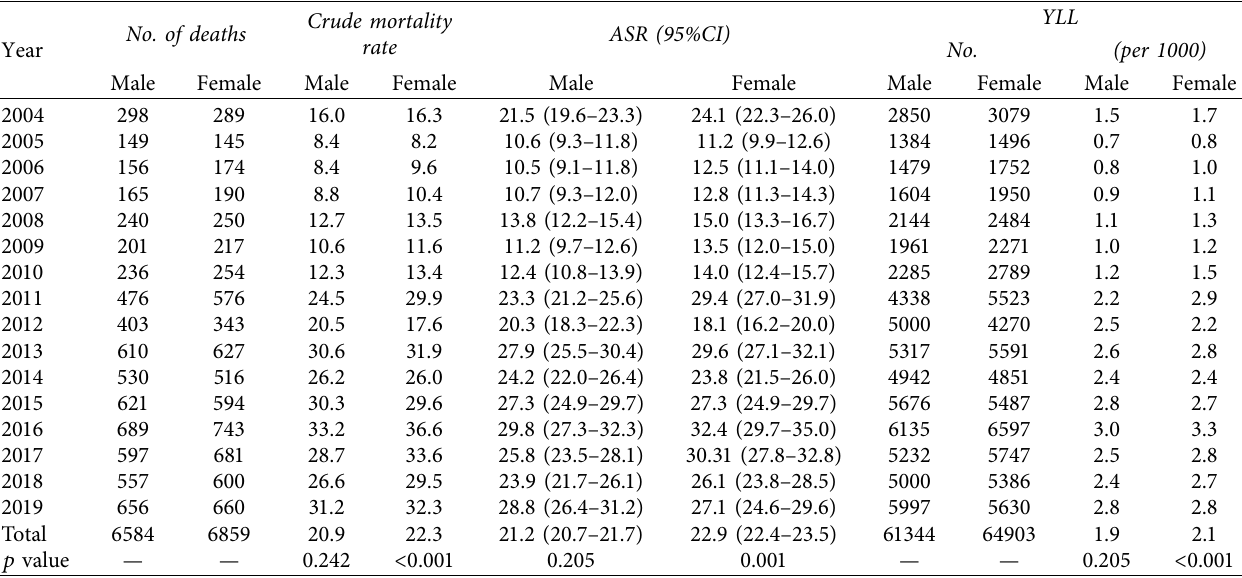
Table 1: Crude and standardized mortality rates (per 100,000 population) and YLL due to hypertension based on gender and year in Fars Province